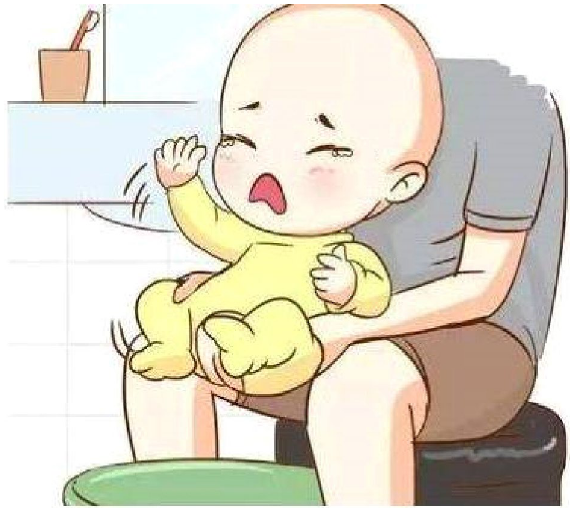
Figure 2. Caregivers can coordinate EC with holding out and separating the thighs (‘Baniao’ in Chinese). (Photo drawn and provided by the first author and the